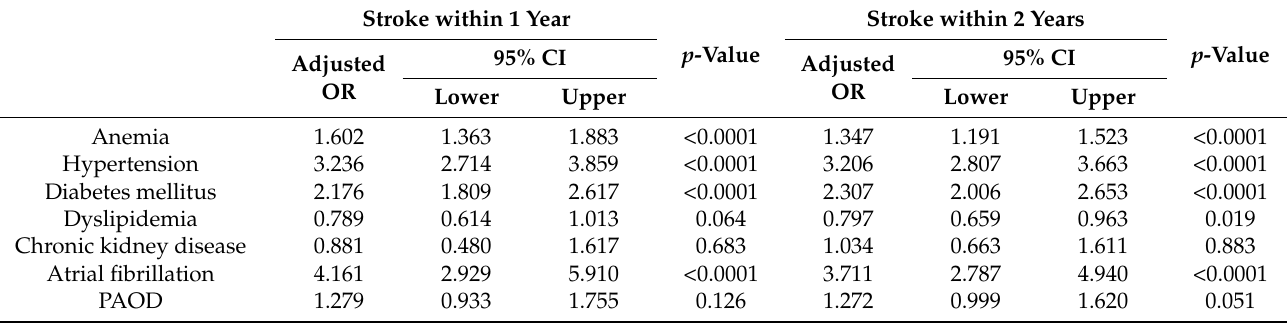
Table 2. Analysis of the risk of ischemic stroke in patients diagnosed with anemia. Stroke within 1 Year p